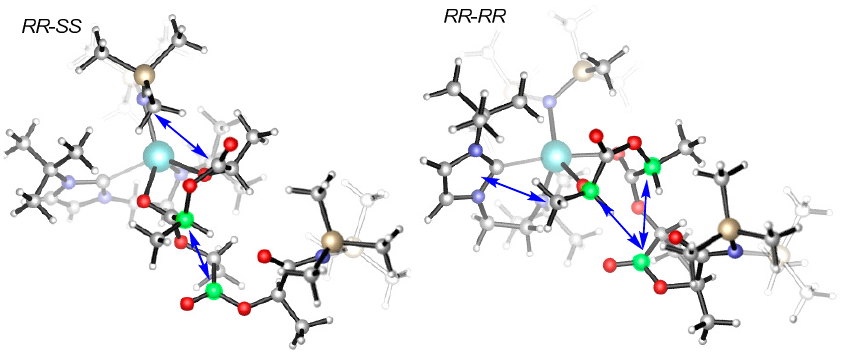
Figure 6. Optimized geometries of TS 7b-8b ; the arrows show repulsive interaction.